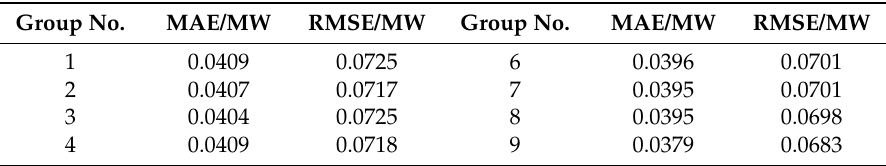
Table 3. Results in different number of groups.